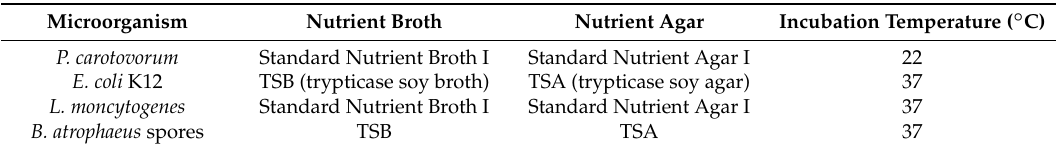
Table 1. Overview of the used nutrient media (broth and agar) as well as incubation temperatures for the microorganisms. All media are obtained from Carl Roth GmbH + Co. KG, Karlsruhe,